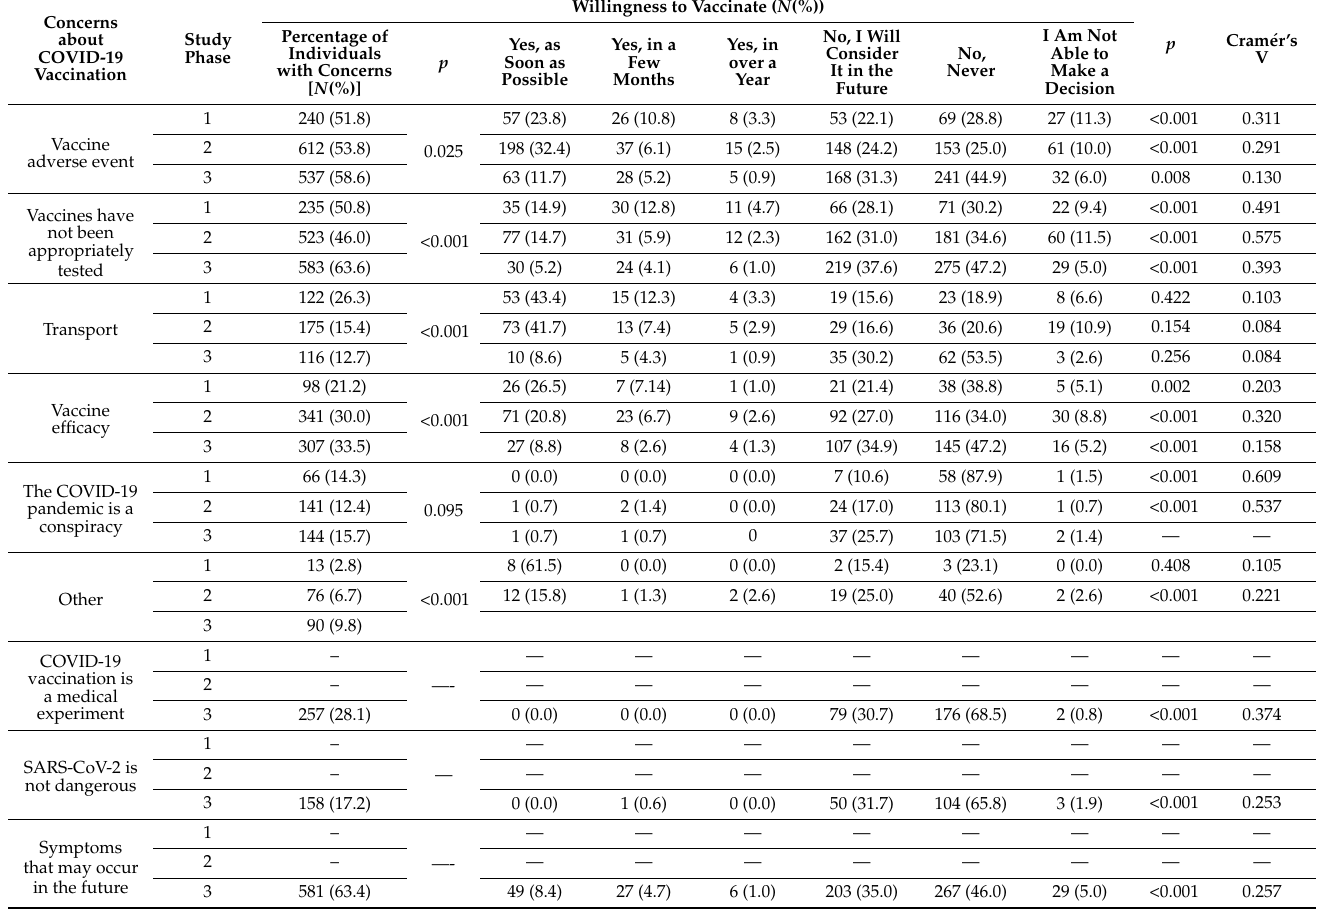
Table 2. Concerns about COVID-19